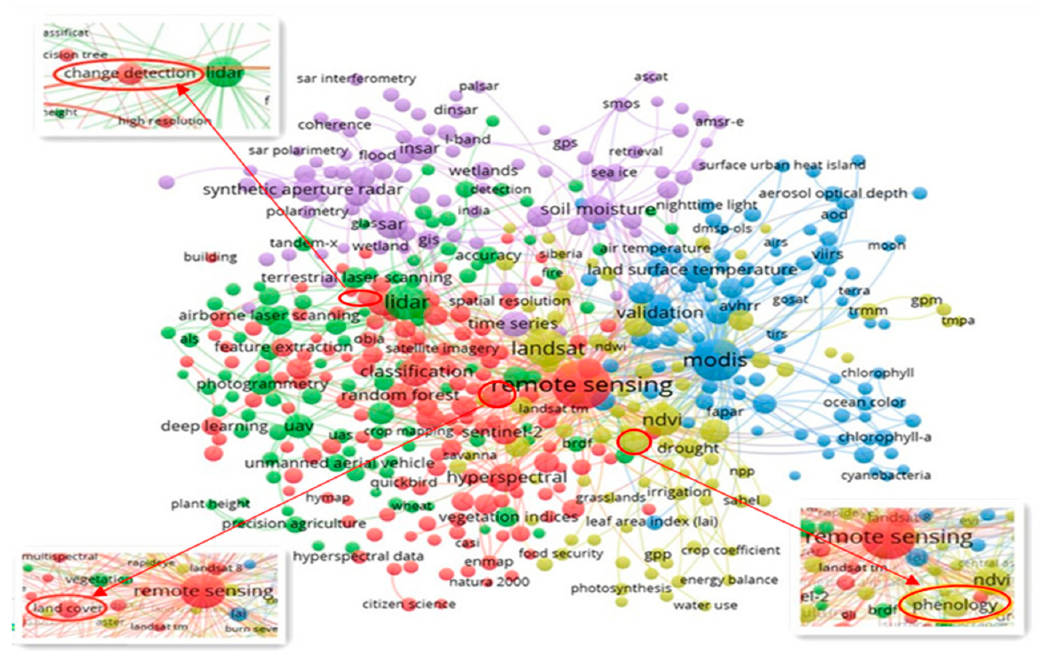
Figure 7. Mapping remote sensing research themes published in Remote Sensing Open Access Journal (RS OAJ) based on the cluster method by VOSviewer. Table 10. The cluster of Remote Sensing Open Access Journal (RS OAJ) research themes.